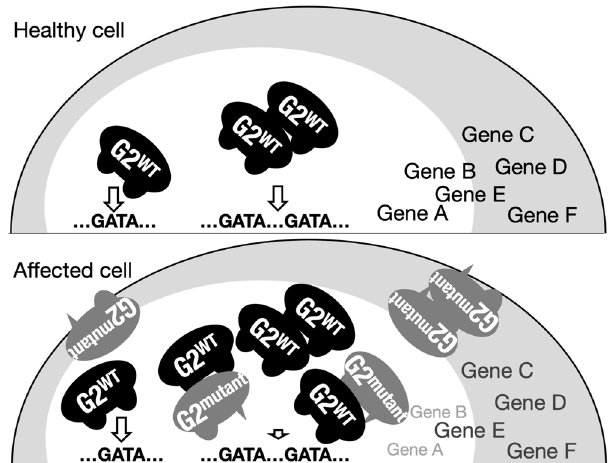
by structural mutation. G2 WT and G2 mutant coexist in cells of affected individuals carrying heterozygous GATA2 gene mutations that produce GATA2 structural mutants. In cases of the G2 mutant with impaired DNA- binding activity to the CF domain, the G2 mutant effectively disrupts the function of G2 WT on the tandem GATA motif and is barely involved in the function of G2 WT on the single GATA motif. Genes whose regulation is heavily dependent on the tandem GATA motif are predicted to be subject to strong interference by the presence of the G2 mutant